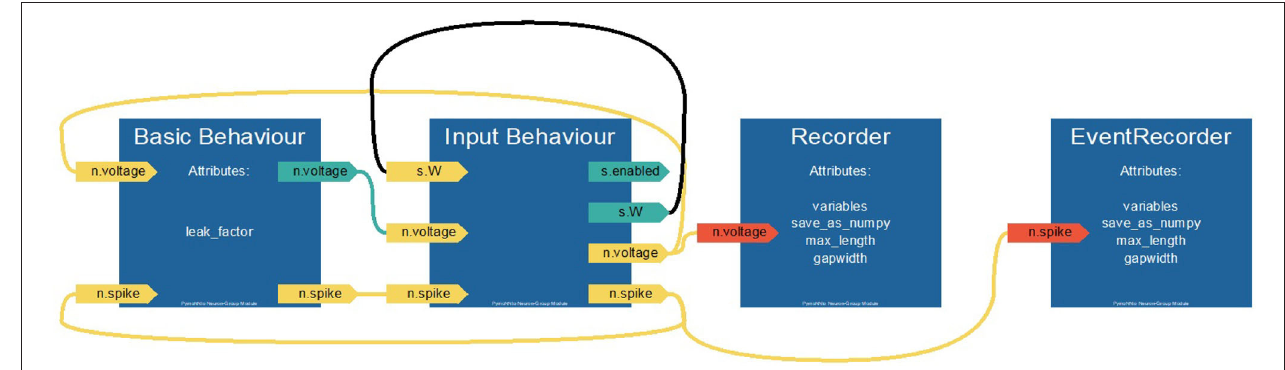
FIGURE 4 | Automatically generated flow chart of the PymoNNto model defined in Code blocks 1–3. Interactions between Basic_Behaviour and Input_Behaviour as well as the respective recorders are shown. Positions of behaviour modules reflect the order of internal execution from left to